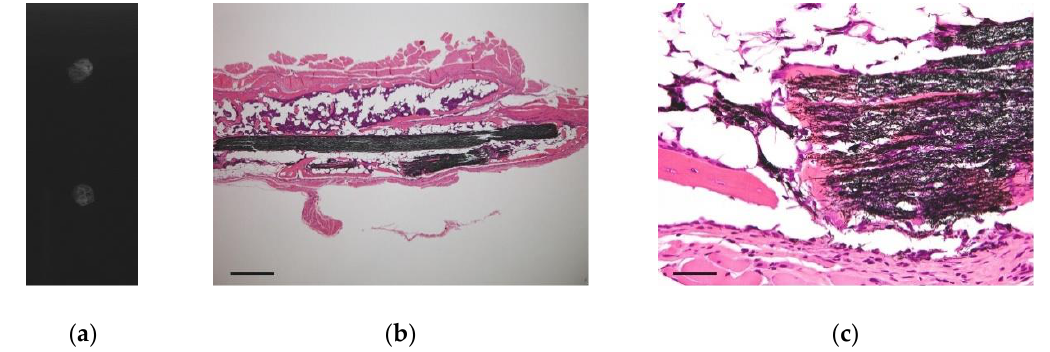
Figure 4. Ectopic bone formed from a rhBMP-2-loaded scaffold in a 250 nm type TCFW implant under the spinal muscle of the mouse. ( a ) Soft X-ray image of ectopic bone. Calcification occurred in the implant, and the trabecular structure is observed; ( b ) Low-power field optical microscopic image of ectopic bone. Bone matrices and bone marrow tissues are formed around the 250 nm type TCFW. Scale bar, 200 μm; ( c ) High-power field optical microscopic image of ectopic bone. Bone matrices are formed between the nanofibers of the implant. Scale bar, 20 μm.